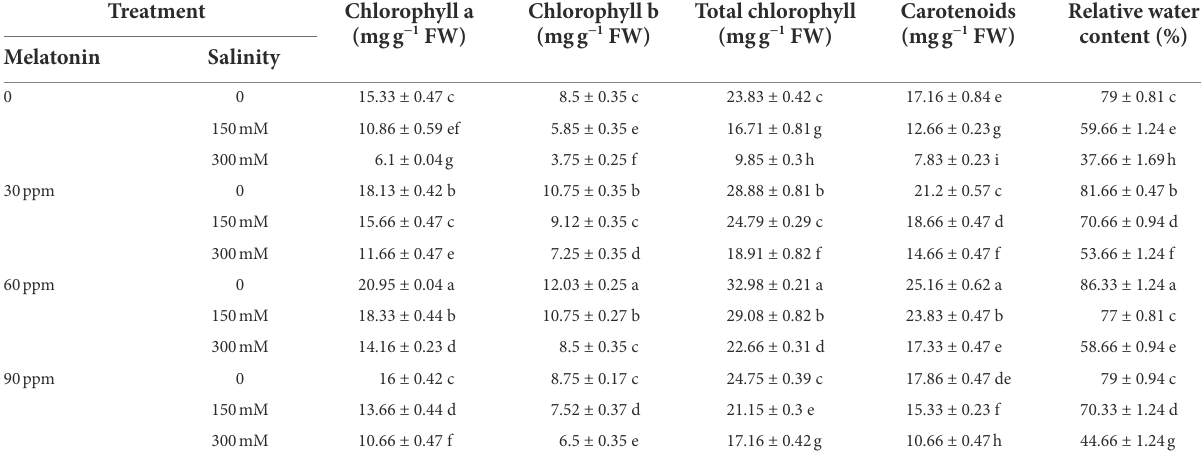
TABLE 1 The mean comparison effects of melatonin concentrations and different levels of NaCl on pigments and relative water content.